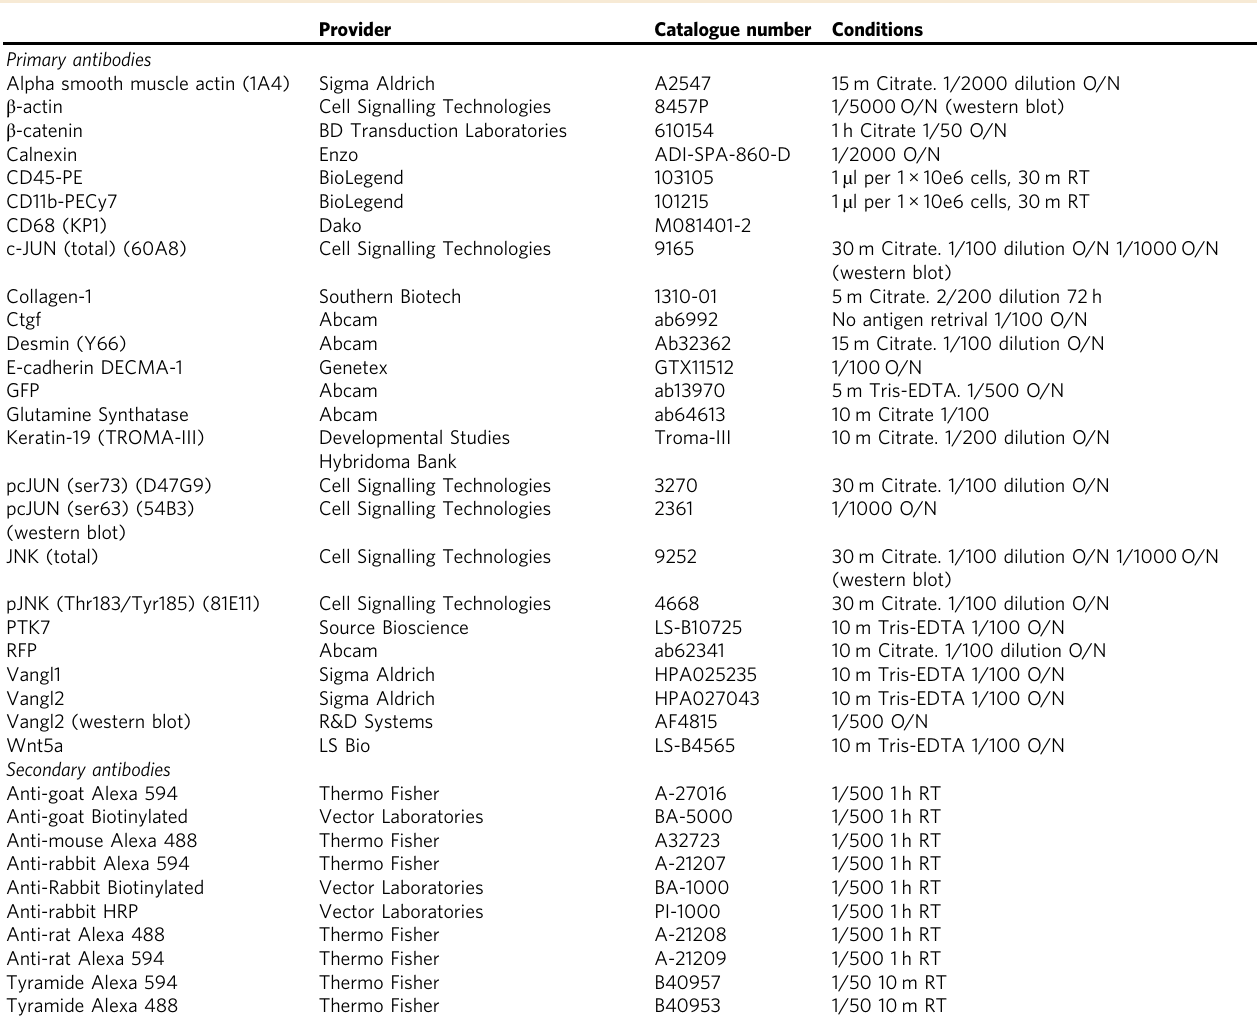
Table 2 Antibodies used in this